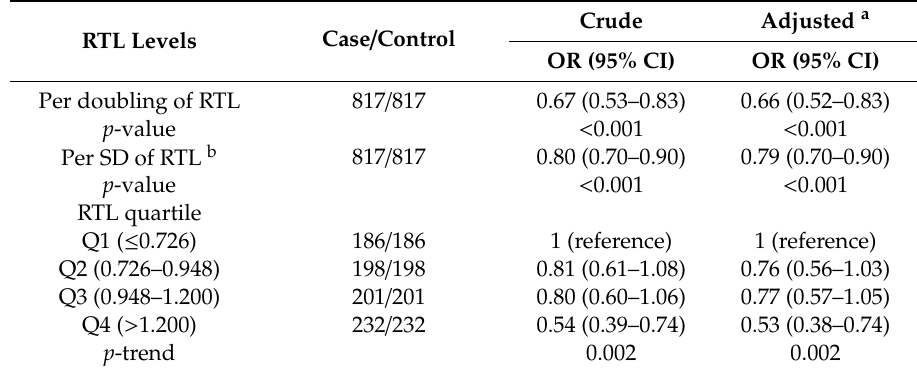
Table 3. Odds Ratio (OR) (95% Confidence Interval (CI)) for Hearing Loss by Relative Telomere Length (RTL) Levels through Conditional Logistic